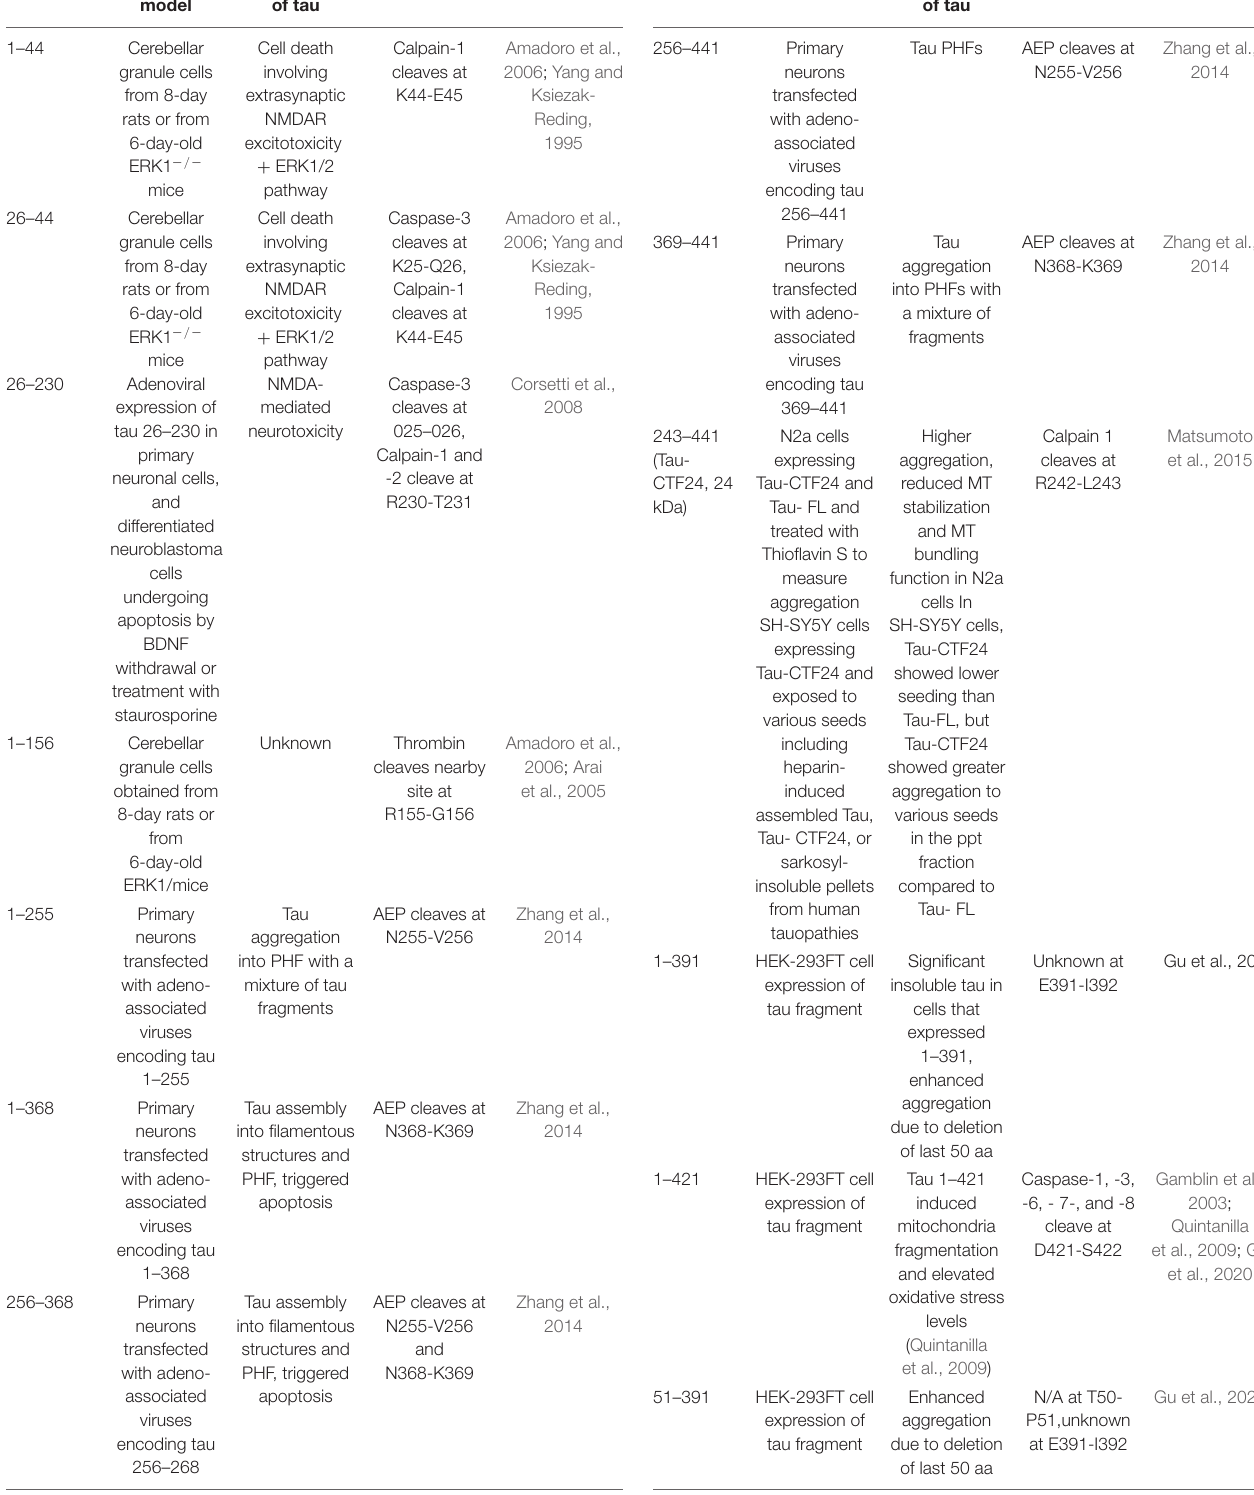
TABLE 2 | Tau fragments in in vitro models displaying cellular